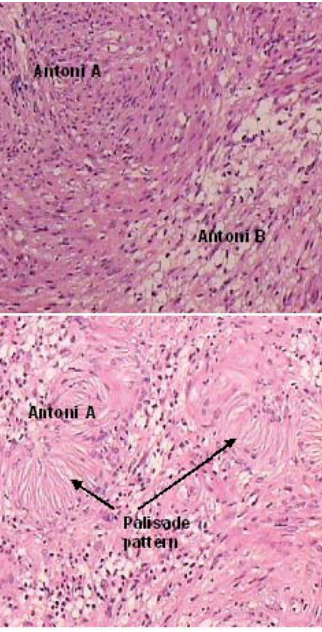
Figure 2 - Microscopic examination. The solid mass consisted of a proliferation of fusiform cells which formed a palisade pattern in some regions (Antoni type A). Other regions were composed of mixoid and degenerative tissue with fewer cells and gelatinous substance (Antoni type B). (HE; 200x)